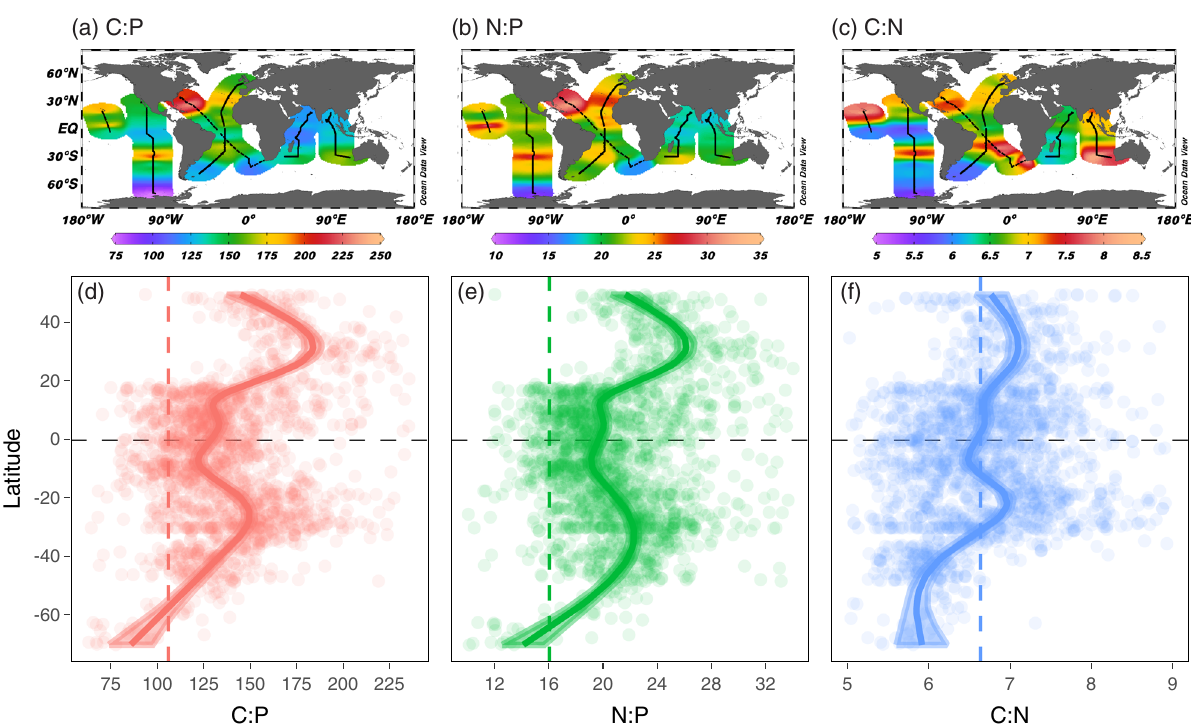
Fig. 2 Global distribution and latitudinal trends of surface ecosystem C:N:P. a – c Individual sampling locations are shown with black points in the global map of C:P, N:P, and C:N. Multi-color shadings in a – c are based on weighted-average gridding from Ocean Data View. d – f Measurements of C:P, N:P, and C:N are plotted against latitude and solid lines represent the Generalized Additive Model (GAM) smooth trends and ribbons corresponding to the 95% con fi dence intervals of latitudinal trends predicted by the GAMs. The dotted vertical lines show the canonical C:N:P Red fi eld ratio of 106:16:1.